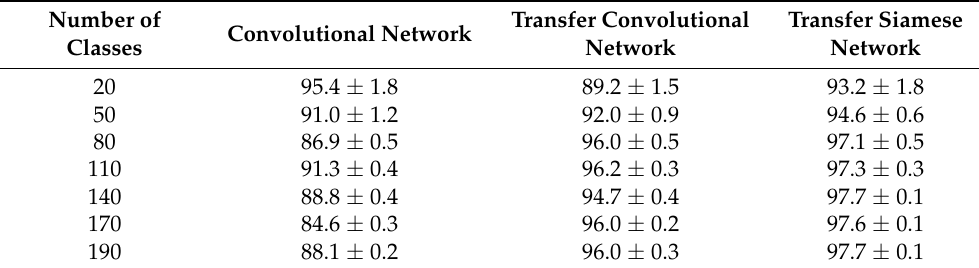
Table 3. Classification accuracy of models using Siamese or not, where the convolutional network is ResNet18.